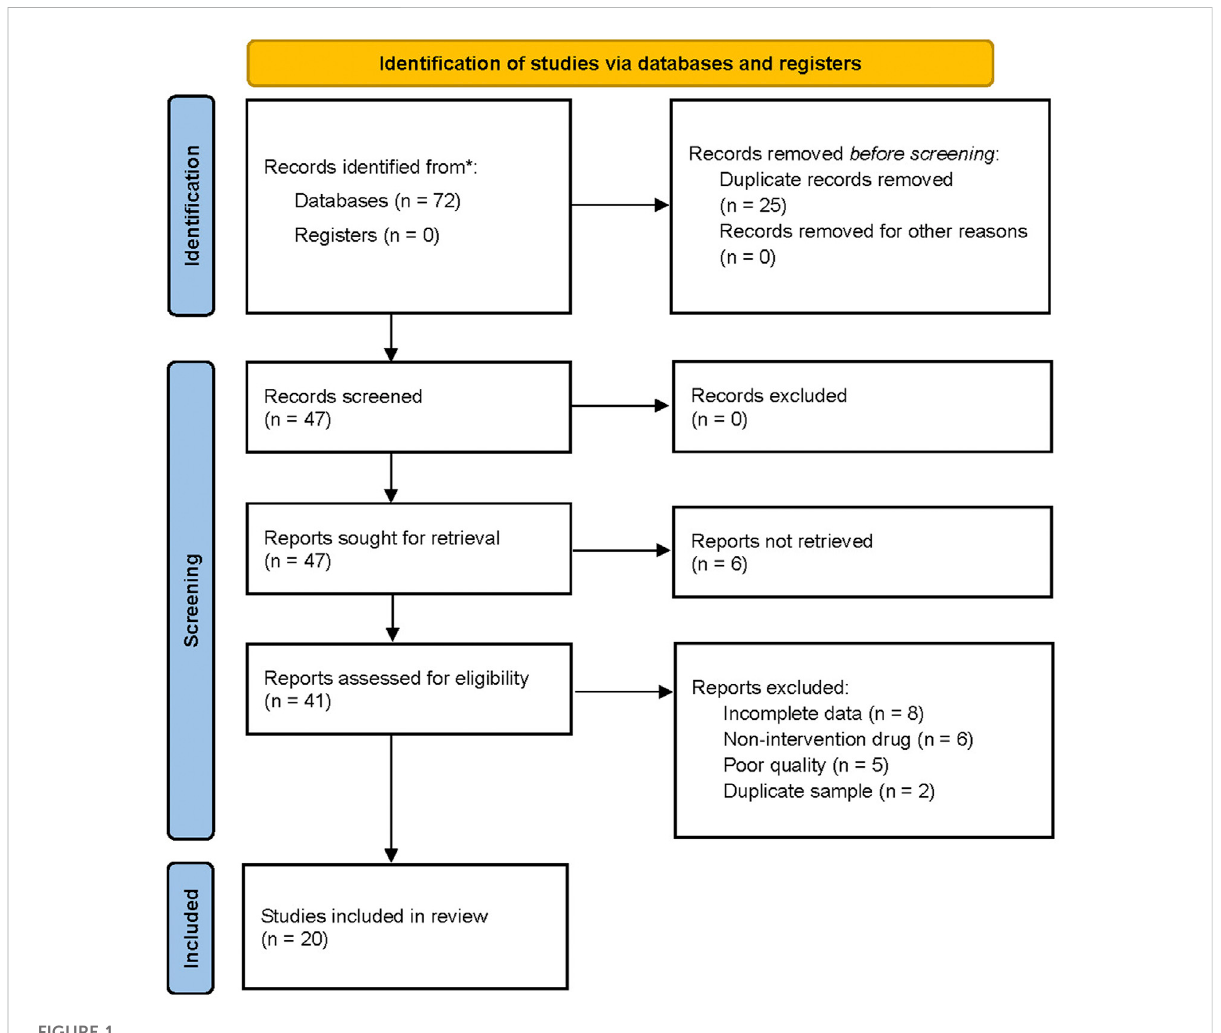
FIGURE 1 PRISMA fl ow diagram of study